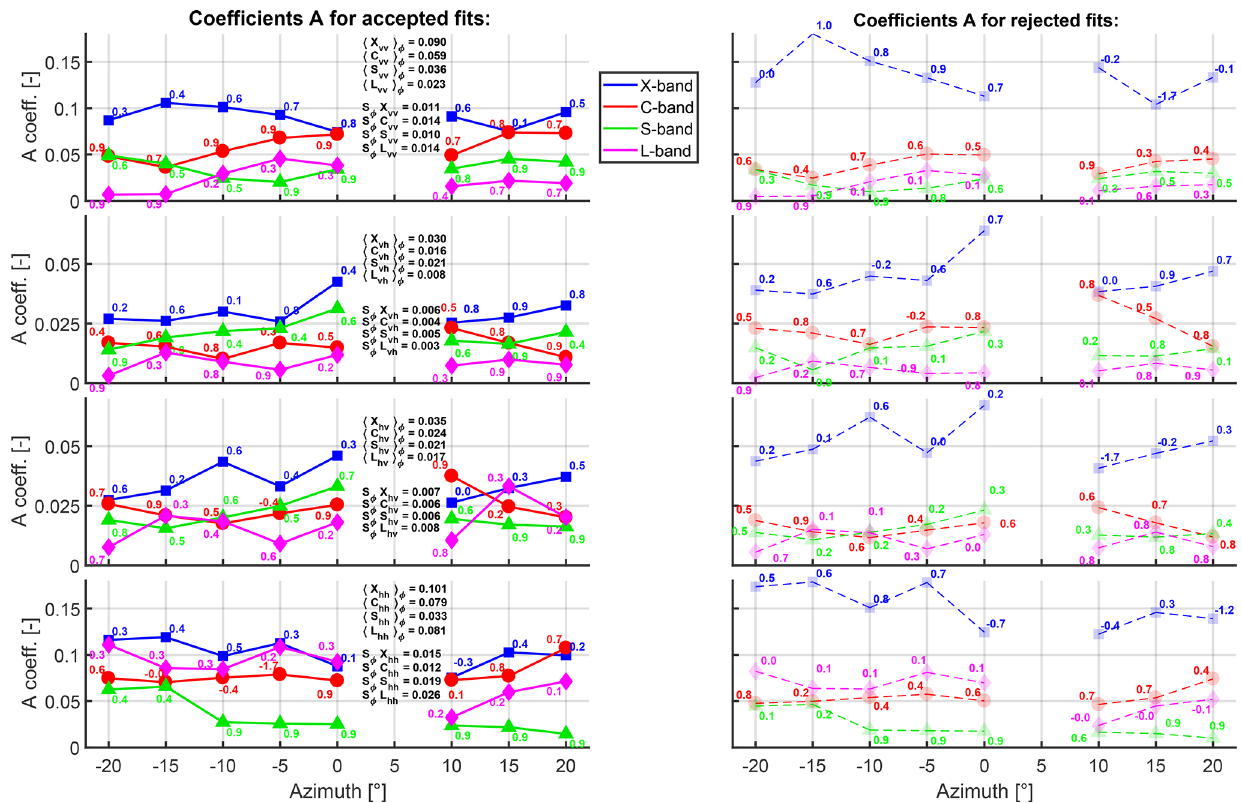
Figure 7. Results of fitting the derived values σ 0 pq over α 0 to model σ 0 ( θ ) = A cos( θ ) B for different azimuth angles φ , bandwidths BW, and polarization channels. The left column shows found coefficients A over φ for best fits with the favourable B value for each BW and polarization, and the right column shows the A coefficients with the less favourable B values. Numbers at data points indicate coefficient of determination ( R 2 ) of individual fits. Values in the centre are average (cid:104) B pq (cid:105) φ and standard deviation S φ B pq over φ , with B = L,S,C, , or X as